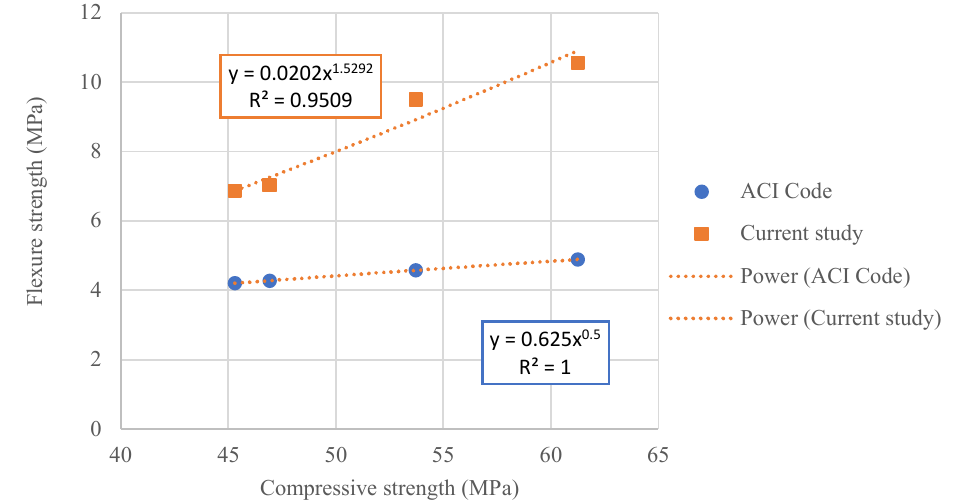
Figure 15. Fitting curve for the flexure strength compared to ACI code equation.